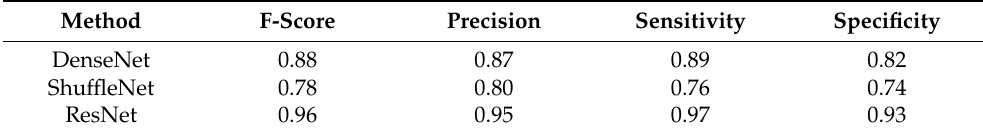
Table 2. Quantitative nest classification results on ROIs-CNN models.